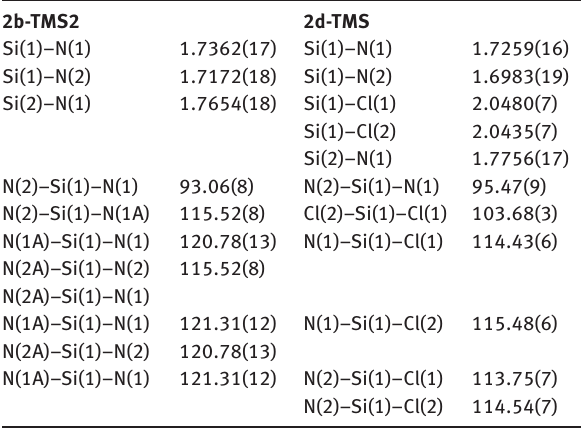
Table 3: Selected geometric parameters (Å, °) of 2b-TMS2 and